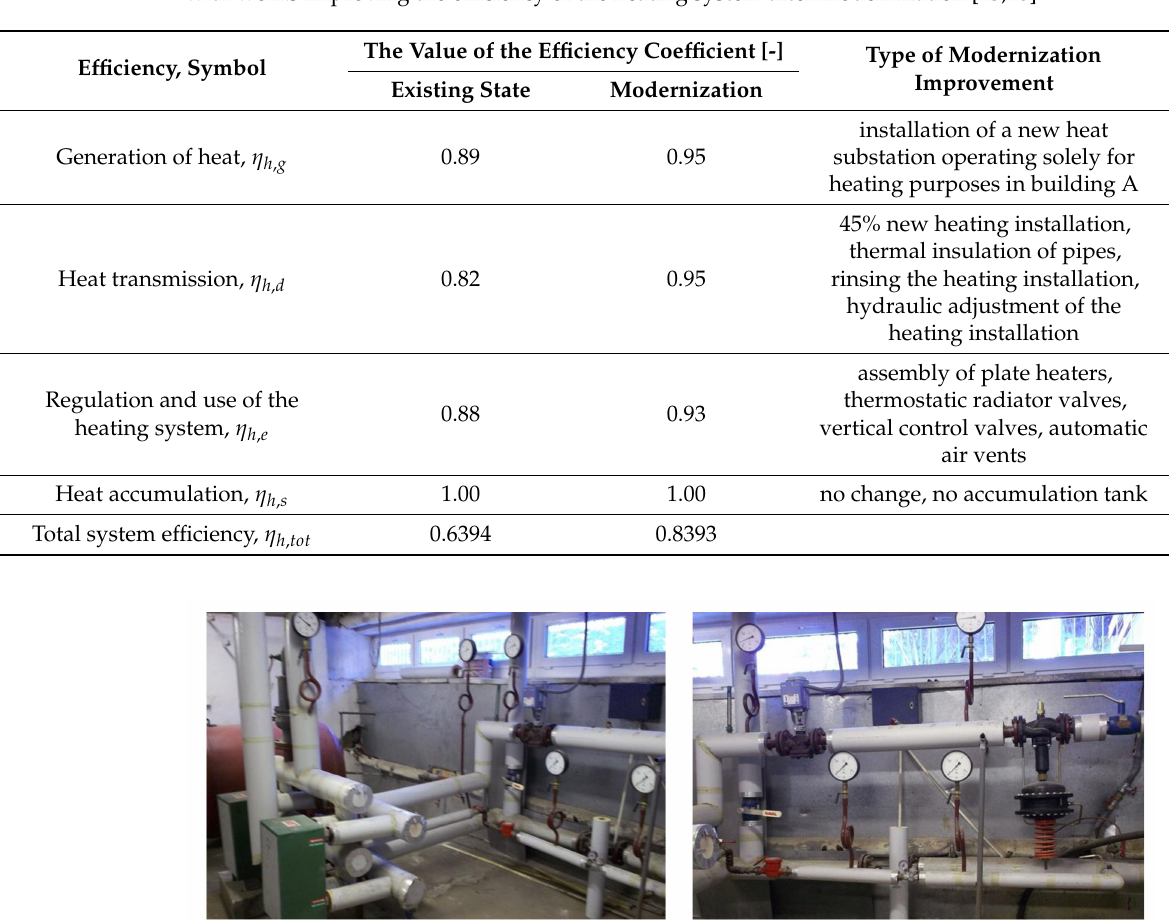
Table 4. Summary of the efficiency of the heating system before and after modernization, together with works improving the efficiency of the heating system after modernization [43,48].